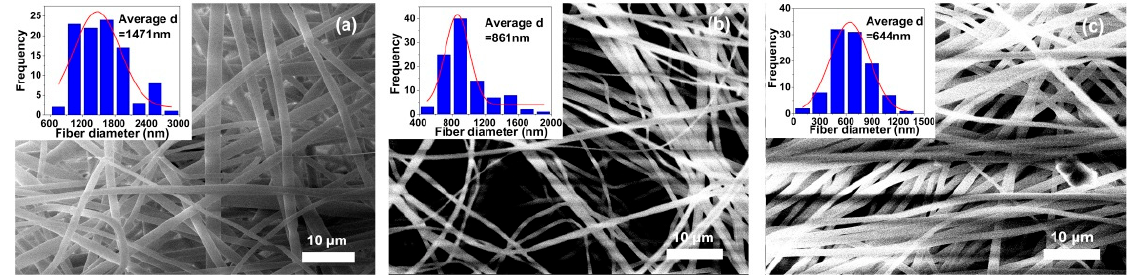
Figure 4. SEM images and average diameters (d av ) of METI NFMs. ( a ) METI-5K; ( b ) METI-10K; ( c ) METI-20K.